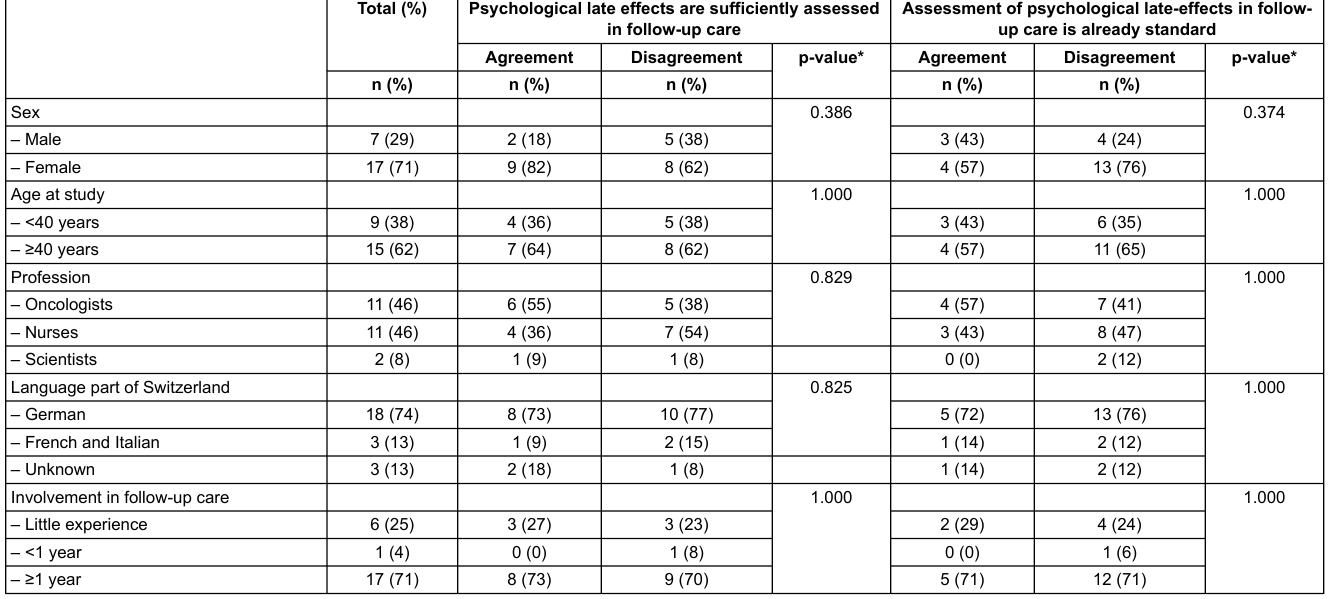
Table 2: Characteristics associated with opinions on the current standard of psychological screening practice in follow-up care. Total (%)